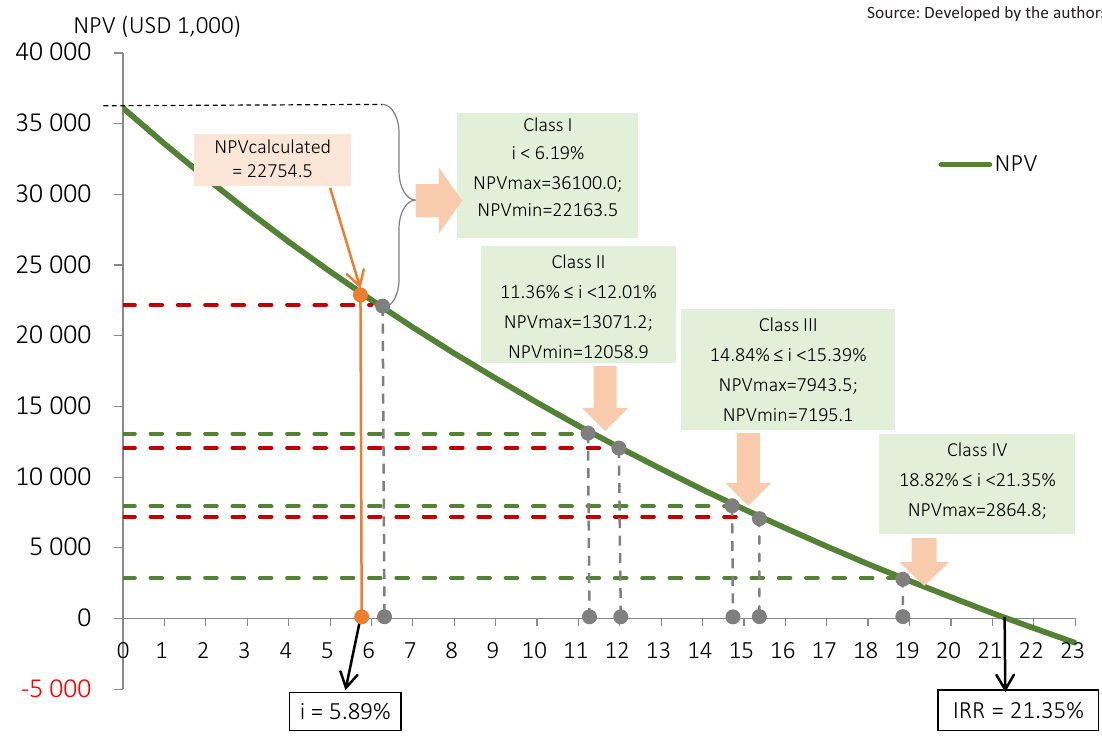
Figure 4. Interval changes of the annual NPV of an investment project while meeting the target financial